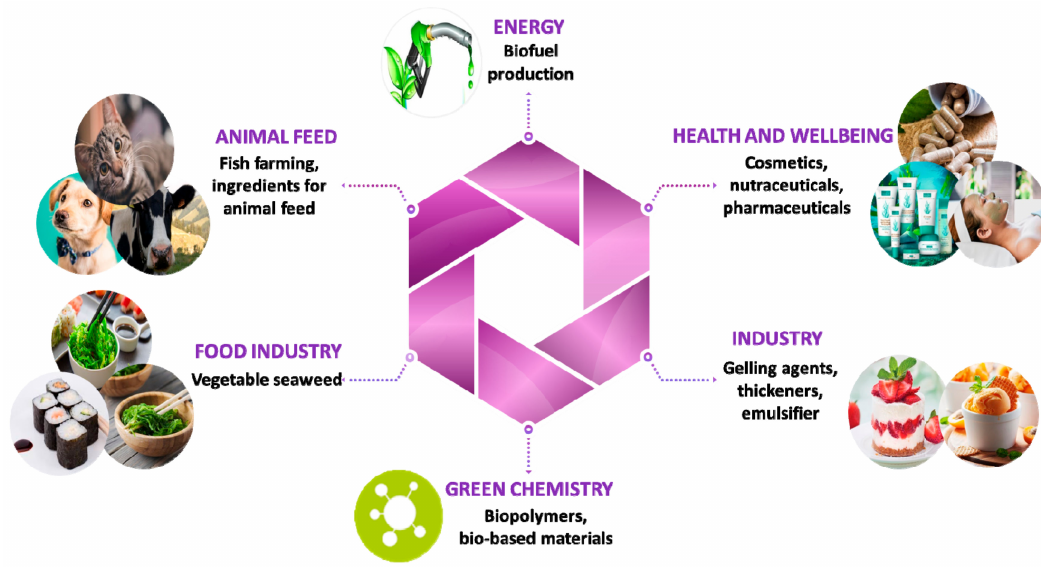
Figure 3. Applications of bioactive algal